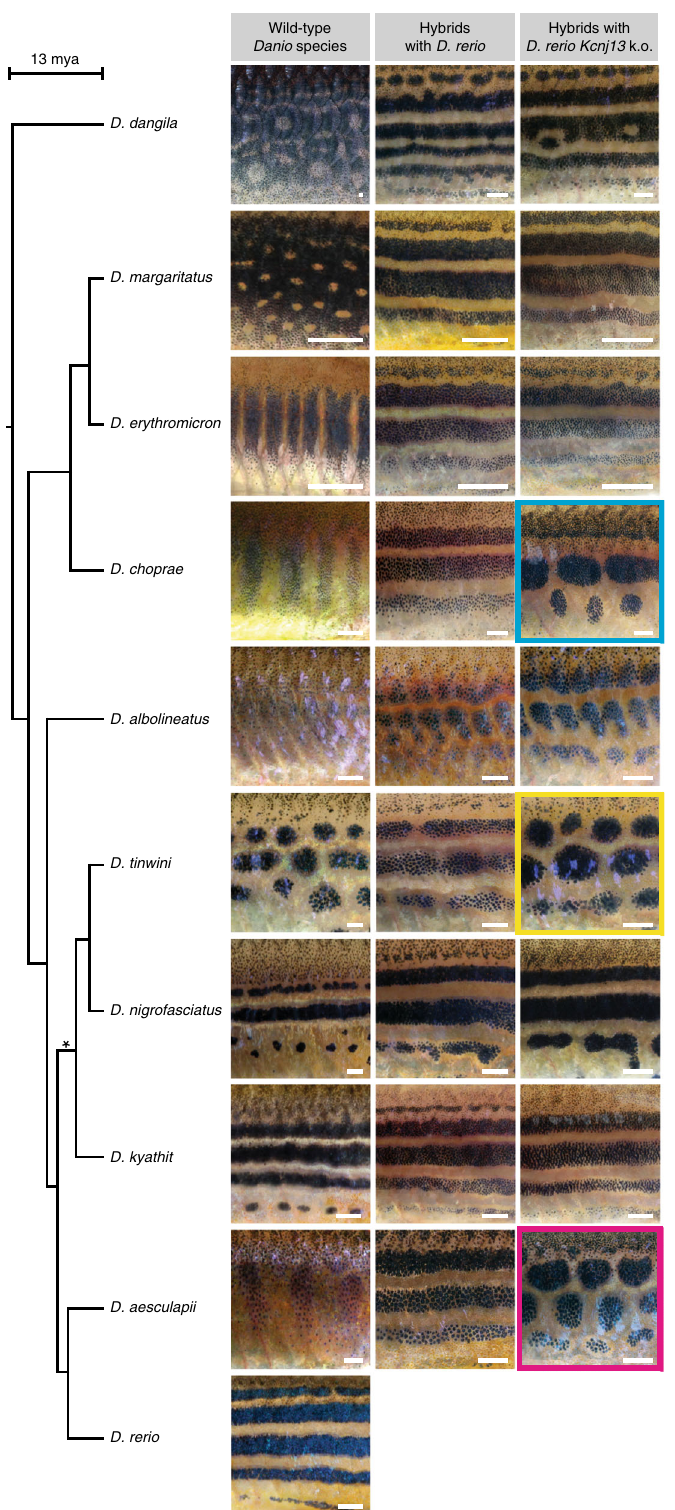
(Supplementary Fig. 5). Whether these amino acid changes are the basis for the potentially repeated and independent evolution of Kcnj13 , and if or how they might affect the function of the channel will require further experiments. The alleles in the three other species cannot simply be loss-of-function alleles, because the hybrid phenotypes differ from the homozygous mutant hybrids and also from D. rerio Kcnj13 mutants. It is also